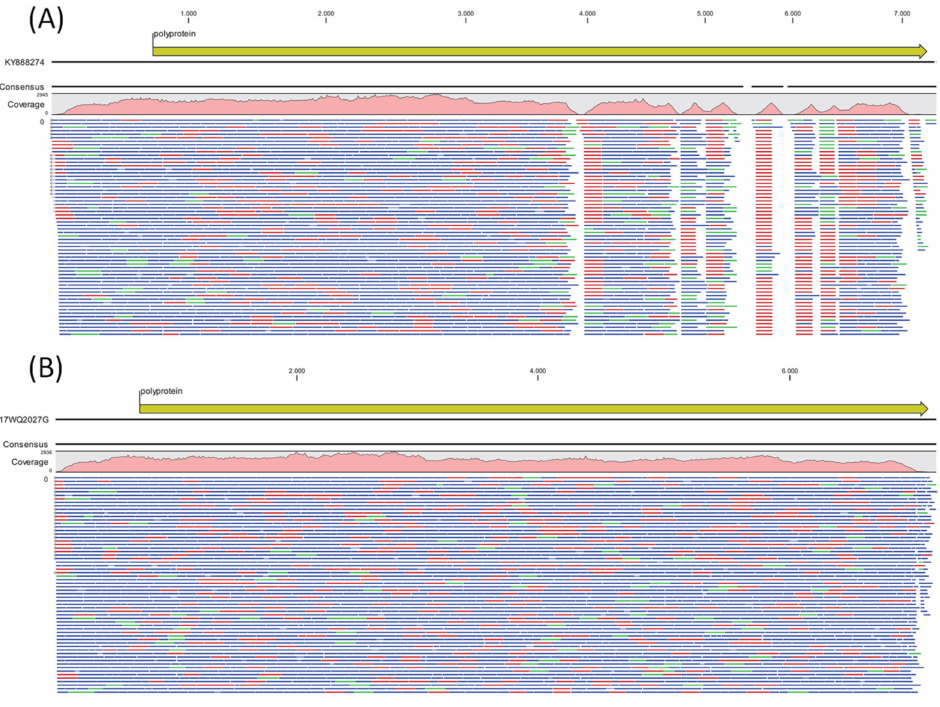
Figure 2. ( A ) Reference mapping of obtained NGS reads against Echovirus E30 strain